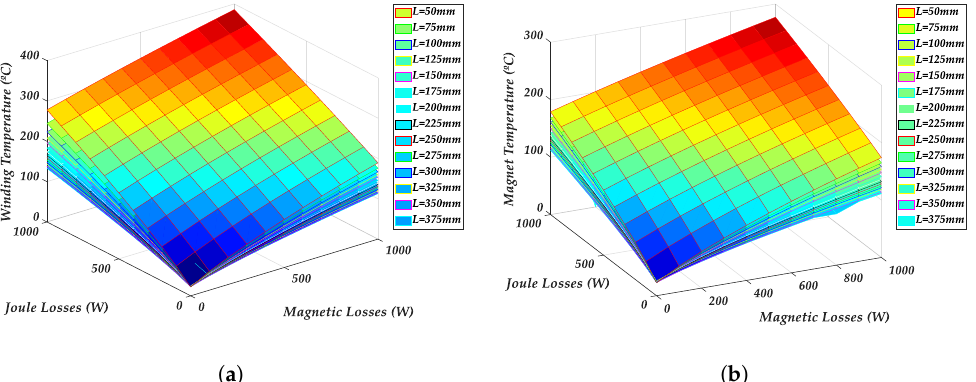
Figure 12. Generated Temperature maps: Temperature vs. Magnet Losses, Copper Losses and Stack length in the naturally cooled machine with Qs36p15 configuration. ( a ) winding temperature map; ( b ) magnet temperature